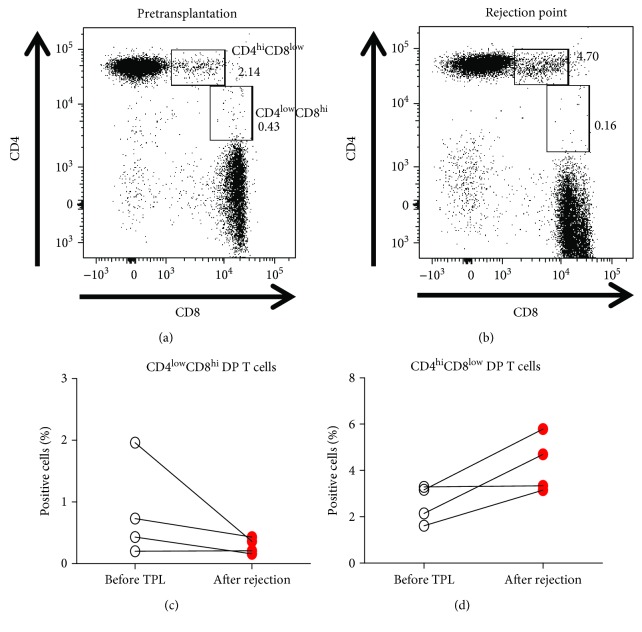
The CD4hiCD8low DP T cell population increased markedly in the graft rejection group. Subpopulations of DP T cells were analyzed pretransplantation (a) and at the point of rejection (b). CD4lowCD8hi DP T cells (c) and CD4hiCD8low DP T cells (d) pretransplantation were compared with those at the point of rejection. TPL: transplantation.